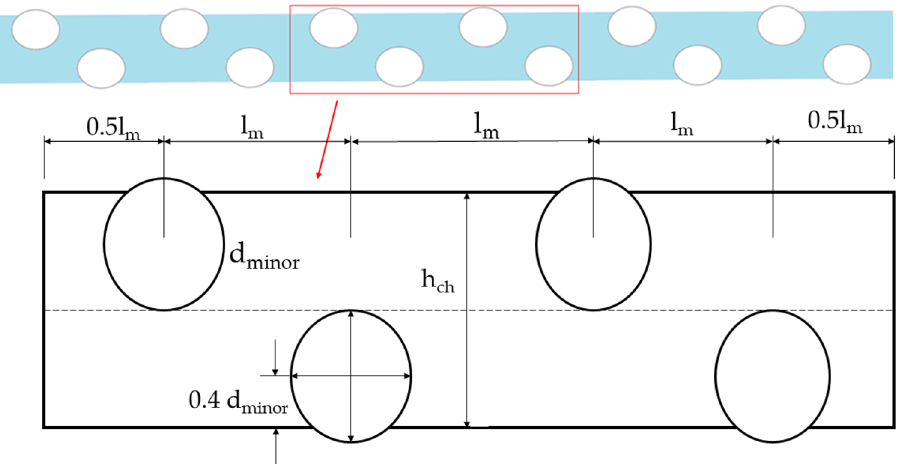
Figure 2. Detailed computational domain of the RoI for strand ratio, R of ‘1’. Where, the channel height, h ch is 0.00364 m and d minor is 0.0026